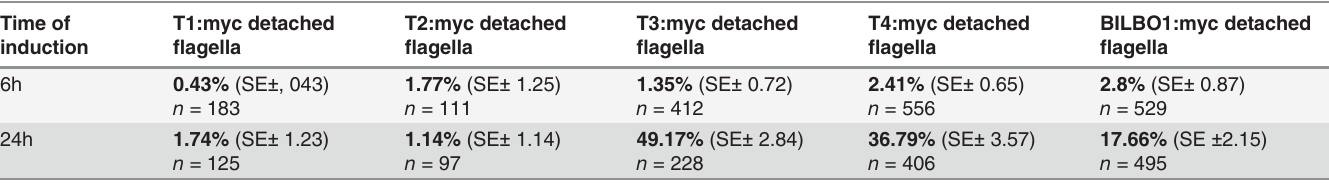
Table 4. T1:myc — T4:myc and BILBO1:myc detached fl agellum phenotypes after expression T. brucei cells. Time of